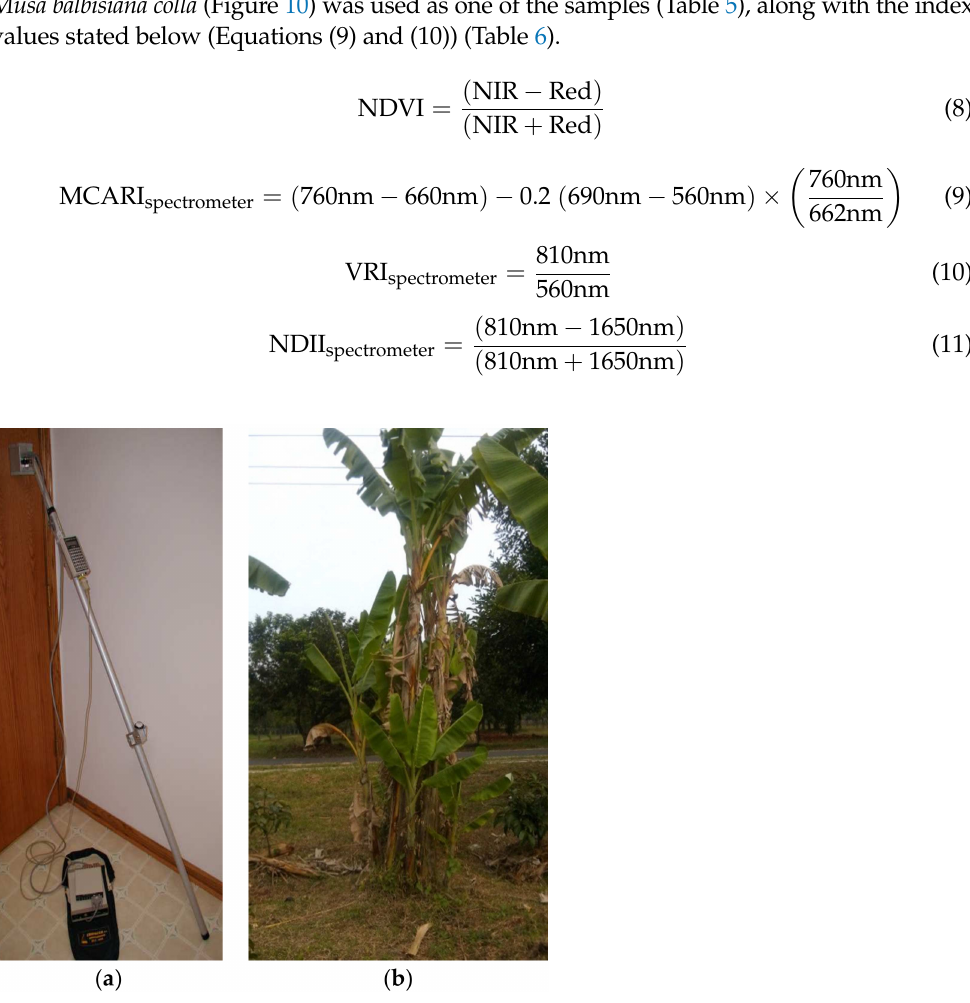
Figure 10. ( a ) The MSR16R used for the spectral reflectance data acquisition of ( b ) Klutuk based on its size, from the shortest to the